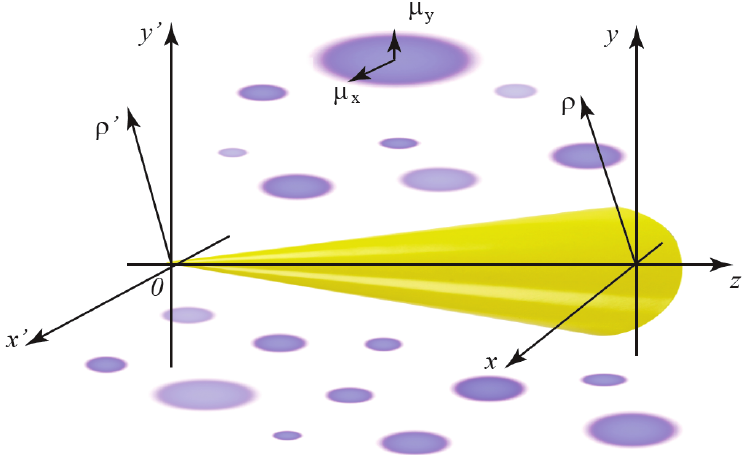
Figure 10. Anisotropic turbulence. Horizontal case. Vectors ρρρ (cid:48) = x (cid:48) ˆ x (cid:48) + y (cid:48) ˆ y (cid:48) and ρρρ = x ˆ x + y ˆ y are 2D position vectors of points in the source and in the field